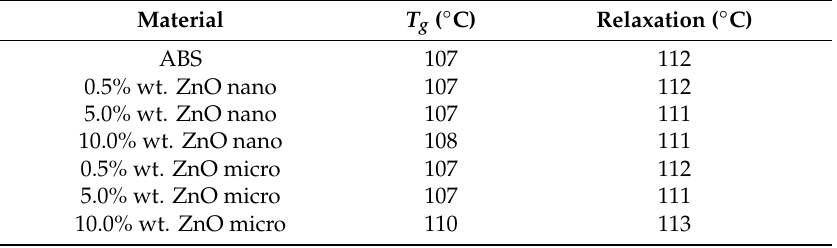
Figure 6. ( a ) Differential scanning calorimetry (DSC) curves for ABS, ABS/ZnO nanocomposites and ( b ) ABS/ZnO micro-composites. ( b ) ABS / ZnO micro-composites. Table 1. T g and relaxation temperatures for materials